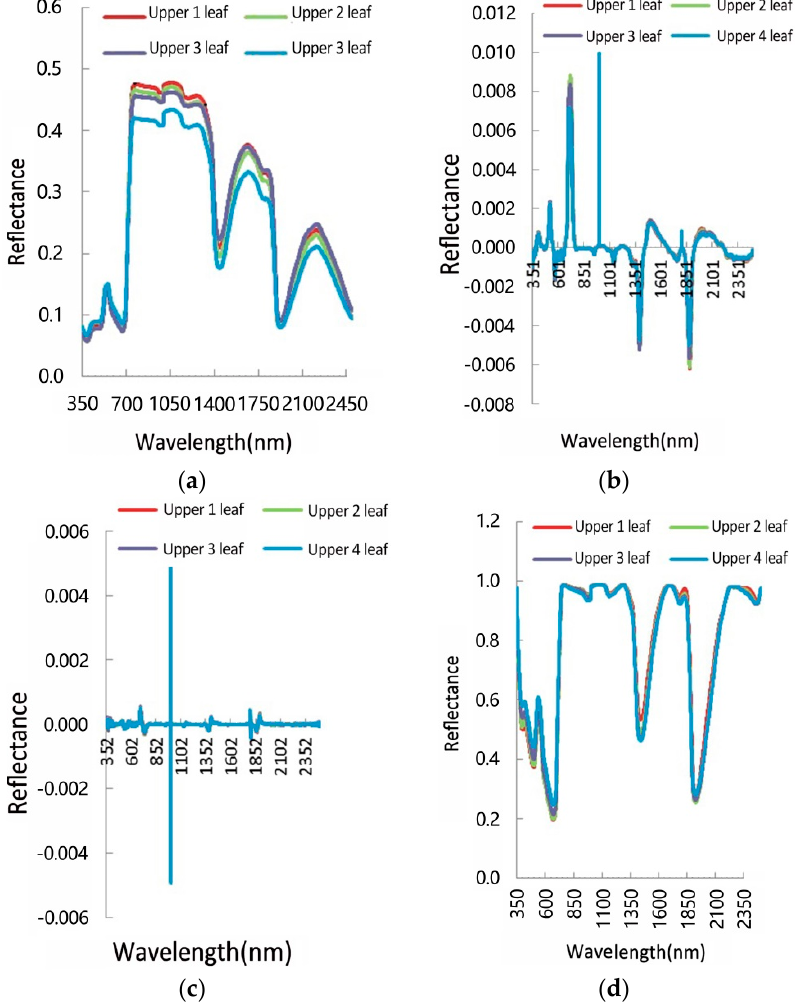
Figure 2. The spectral curves for different leaf positions of wheat. ( a ) Leaf original spectral curves; ( b ) first-order differential spectral curves; ( c ) second-order differential spectral curves; ( d ) leaf continuum removal spectral curves. Table 2. Correlation analysis of different transform spectra and leaf nitrogen content in different leaf positions and the results of screening sensitive